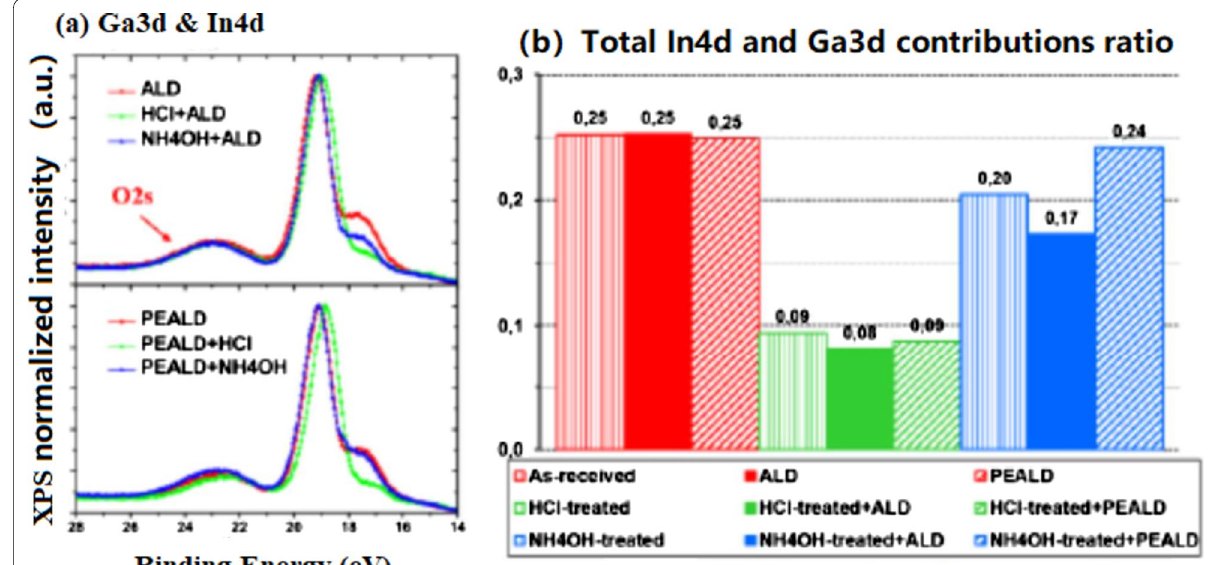
Fig. 14 a Superposition of normalized Ga3d‑In4d spectra for ALD and PEALD samples without, with HCl or with NH 4 OH surface treatment, b Ga3d‑In4d ratios for the same samples in comparison with Al 2 O 3 free surfaces [86]